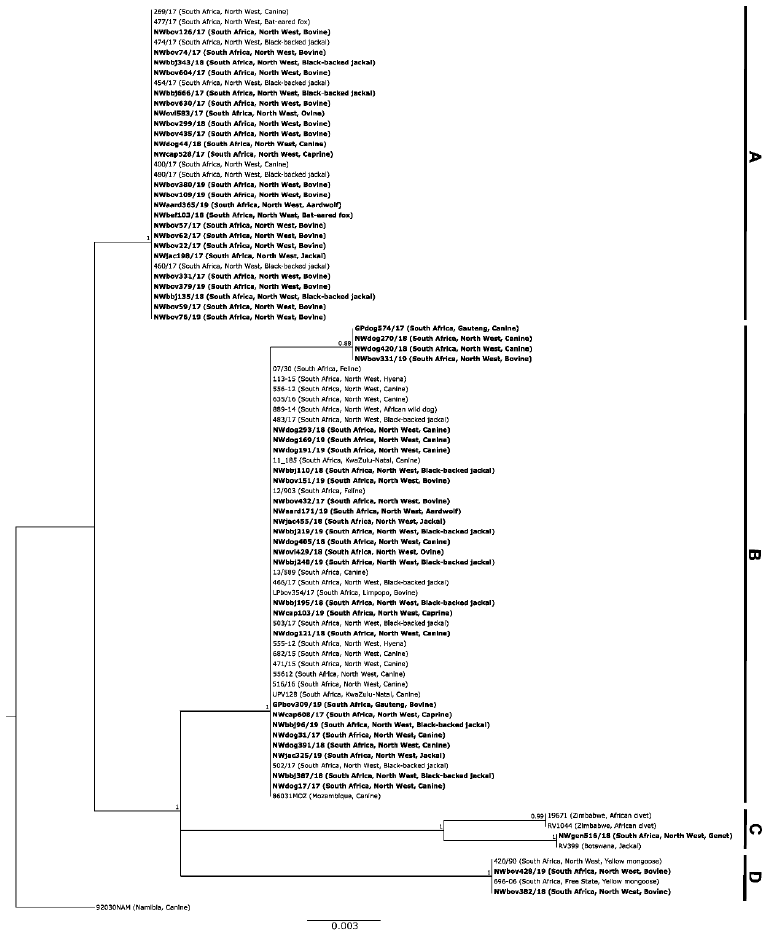
Figure 1. Maximum clade credibility tree for partial N gene sequences derived from South Africa, Zimbabwe, and Botswana (Table S1). The horizontal branch lengths are proportional to the homology between sequences within and between groups and all branches with a posterior probability of ≤0.75 were collapsed. A canine sequence from Namibia (92030NAM) was used to root the tree. The new sequences generated in this study are shown in bold (Table S1). All sequences in Clade A and Clade B belong to the Africa 1-b lineage, while the sequences in Clade C and Clade D belong to the Africa 3 lineage (Table S1).